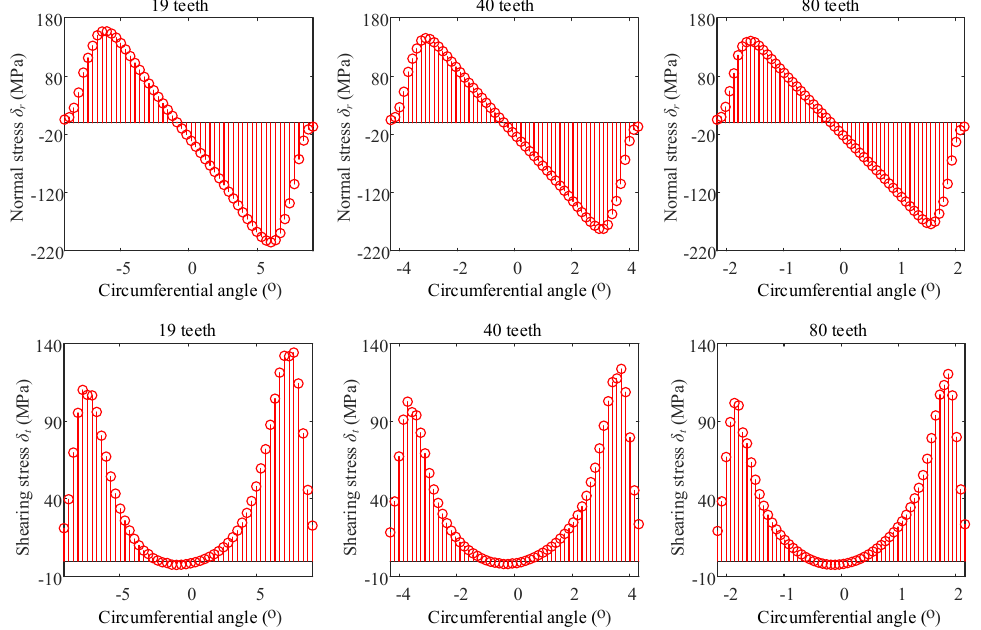
Figure 9. Effect of number of teeth on tooth root stress distribution. Figure 9. E ff ect of number of teeth on tooth root stress